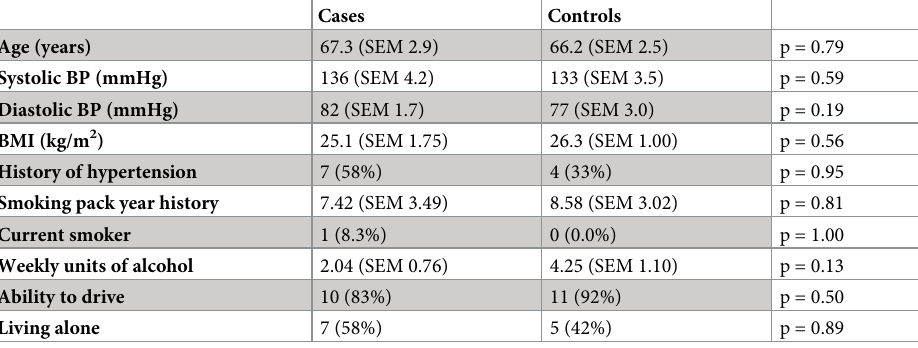
Table 1. Baseline characteristics in cases and controls.